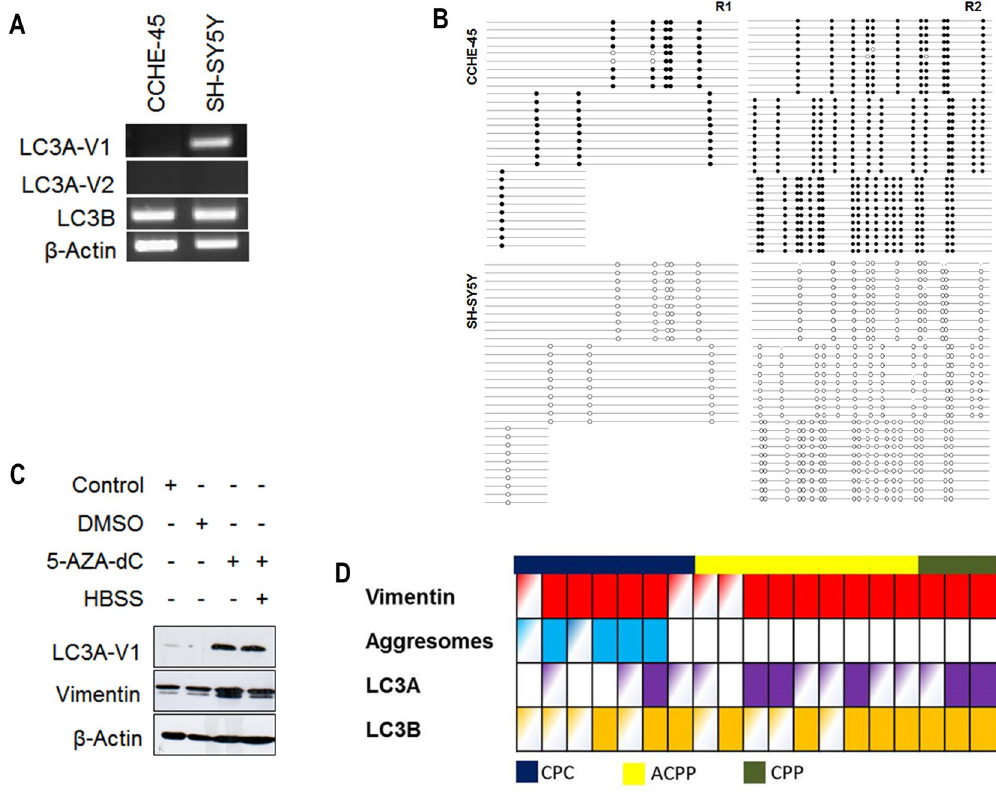
Figure 3. Inactivation of LC3A expression in choroid plexus carcinoma. ( A ) Expression of LC3A-V1 , LC3A-V2 and LC3B were determined using RT-PCR in CCHE-45 and SH-SY5Y cell lines. β -actin was used as an internal control. ( B ) Bisulfite modified DNA PCR products from CCHE-45 and SH-SY5Y. Primers were designed to amplify CpG island (R1 and R2) upstream of LC3A-V1 using bisulfite sequencing. Diagrams show methylated CG dinucleotide in CCHE-45 R1 and R2 with no methylation detected in SH-SY5Y. ( C ) Western blot analysis of CCHE-45 cells treated with 10 µ M 5-AZA-dC for 4 days then serum starved in HBSS for 2 hours. LC3A protein was restored following 5-AZA-dC treatment. No change in vimentin protein levels was detected. ( D ) Schematic representation for immunostaining of 19 cases CPC (blue), ACPP (yellow) or CPP (olive). FFPE tissue sections were stained with vimentin, LC3A or LC3B. Solid, partial and clear color indicates positive, focal or negative stain